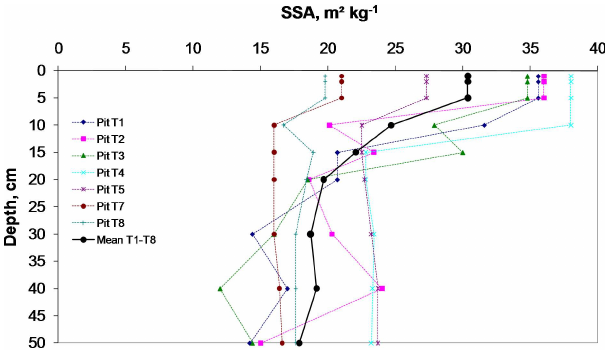
Fig. 8. SSA profiles of group T pits along the logistical traverse. There is no T6 pit because of bad weather that day.